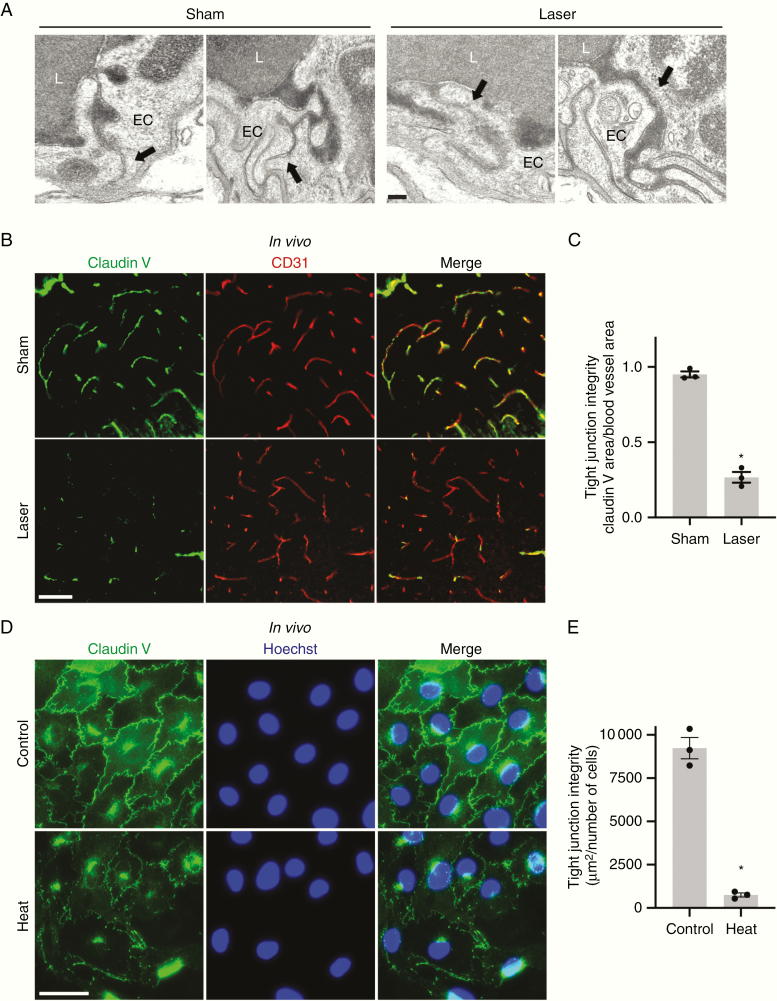
LITT disrupts brain endothelial cell tight junctions. (A) Representative transmission electron microscopy images are shown following intravenous HRP injection in sham and laser-treated brains (n = 3 for each condition). Intact tight junctions (arrows) are observed in the control brain whereas tight junction aberrancies (arrows) are seen in the laser penumbra of laser-treated brain. L, blood vessel lumen; EC, endothelial cell. Scale bar = 100 nm. (B) Brains of animals treated with LITT or sham treatment were processed on post-LITT day 3 for claudin V immunofluorescence. CD31, endothelial cell marker. Representative images are shown (n = 3 for each condition). Scale bar = 50 µm. (C) The integrity of brain endothelial cell tight junctions in mice treated as in B was quantified by area of claudin V immunostaining divided by the area of blood vessels (CD31 immunostaining, µm2). Data represent mean ± SEM. LITT significantly decreased tight junction integrity compared to sham (n = 3 for each condition, t-test, *P < .0001). (D) Brain endothelial cells (bEnd.3) were cultured, and claudin V immunofluorescence performed after exposure to heat (43°C) for 90 min. Representative images are shown (n = 3 for each condition). Scale bar = 50 µm. (E) The integrity of tight junctions in brain endothelial cells treated as in D was quantified by area of claudin V immunostaining divided by cell count. Data represent mean ± SEM. Heat significantly decreased tight junction integrity compared to control (n = 3 for each condition, t-test, *P < .01).